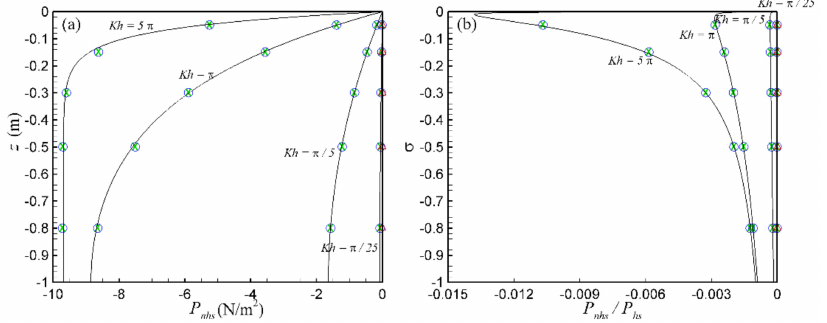
Figure 3. ( a ) The vertical distribution of non-hydrostatic pressure and ( b ) the relative ratio between non-hydrostatic pressure and hydrostatic pressure under wave crest for linear dispersive waves: analytical solution (solid lines), FNHS (fully non-hydrostatic) mode (circles), QNHS (quasi non-hydrostatic) mode (X marks), and HS (hydrostatic) mode